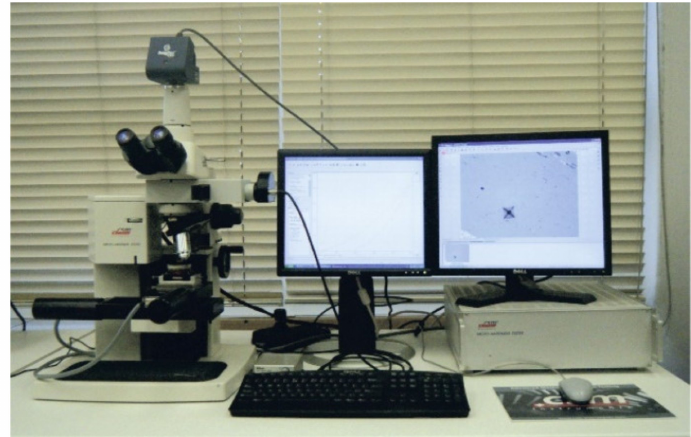
Figure 3. Stand for microhardness tests using the Vickers